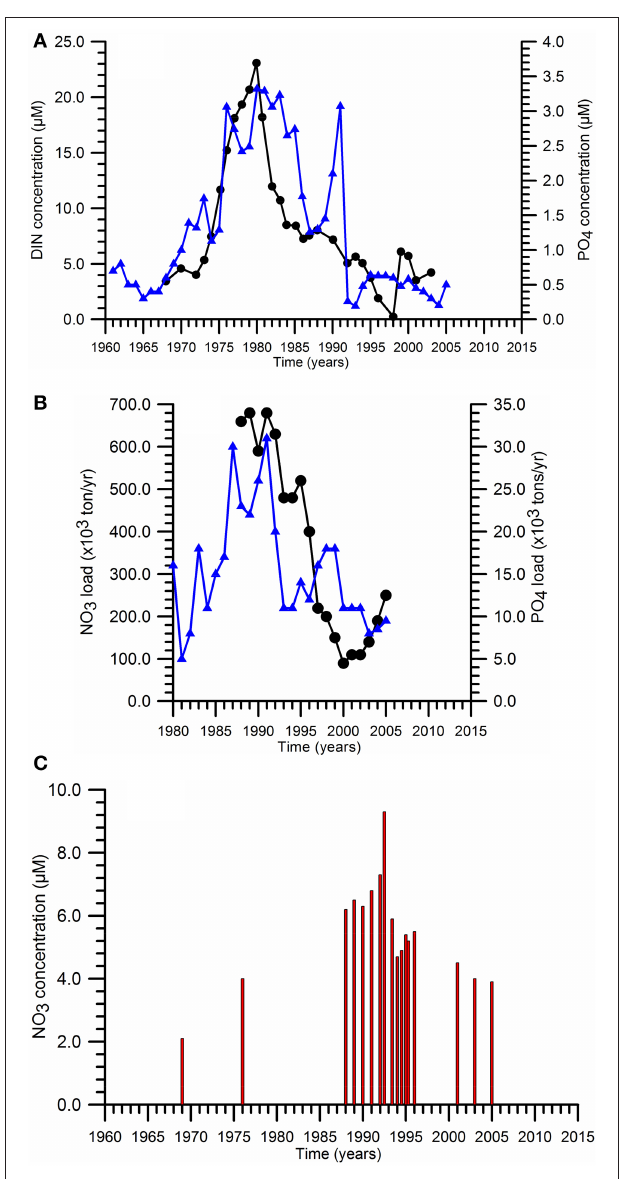
FIGURE 4 | Temporal variations of (A) the annual mean surface nitrate ( (cid:4) ) and phosphate ( • ) concentrations within the northwestern (Romanian and Ukranian sectors) coastal-inner shelf waters, (B) River Danube annual dissolved inorganic nitrogen (DIN) and phosphate (P-PO4) loads, (C) maximum nitrate concentrations measured at the chemocline of interior deep